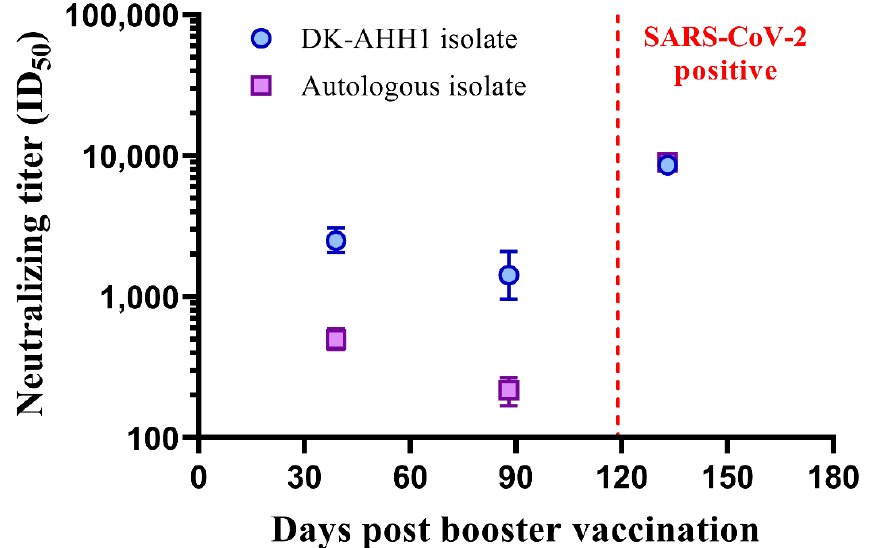
Figure 4. SARS-CoV-2 reinfection in mRNA–mRNA vaccinated individual. The graphs show the longitudinal neutralizing titers for V-67, who was infected with SARS-CoV-2 after completed prime- boost vaccination with a mRNA–mRNA (Comirnaty ® ) regimen, against the DK-AHH1 isolate (blue circles) and the autologous isolate (purple squares), with the infection point marked with a red dotted line (day 119 post booster vaccination).